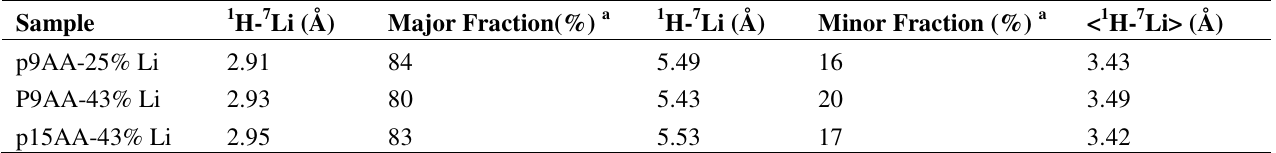
Table 2. Maximum, relative fraction and average distance for the different 1 H- 7 Li environments predicted from MD